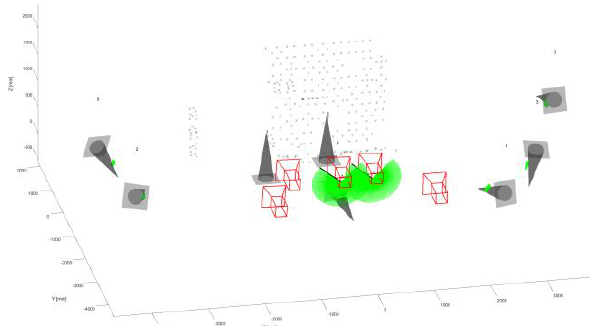
Figure 7 . Visualization of the network geometry: Consisting of the cones for LS measurement, four camera poses, two LS poses (green fans) and the wall targets (dots) From these data, two viewpoints of the mobile platform were selected for the feasibility study. As already mentioned in section 2.5, an adapted version of the bundle block adjustment of (Mader et al., 2014) was used to calculate the positions of the laser scanner projection centre and the values for lever-arm and boresight of the laser scanner to the camera. Figure 7 shows the result graphically. In addition to the already explained reference field (cone and wall reference points), four camera and two laser scanner poses (green fans) are shown.